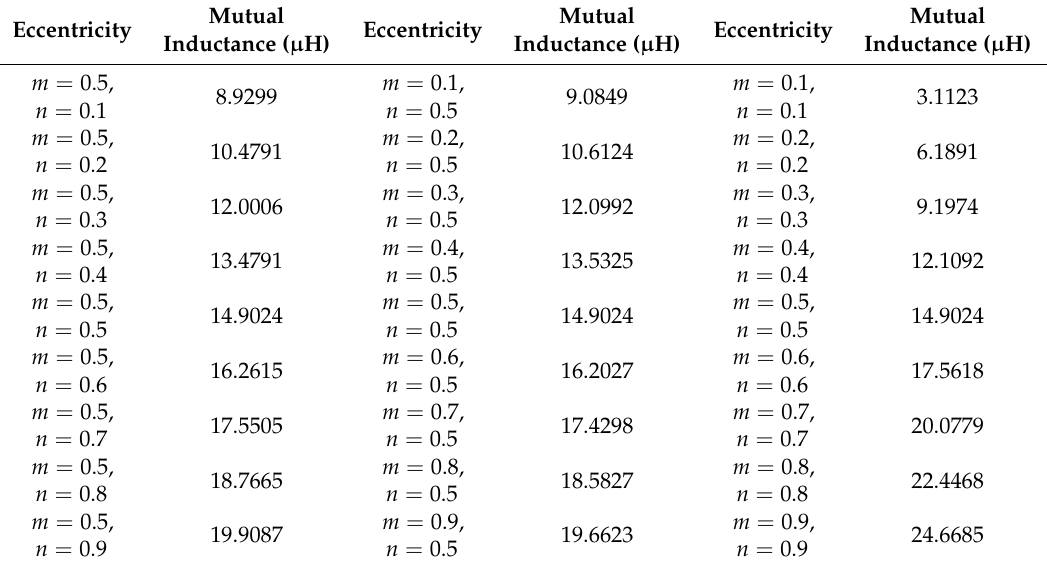
Table 3. Mutual inductance values of di ff erent eccentricities.